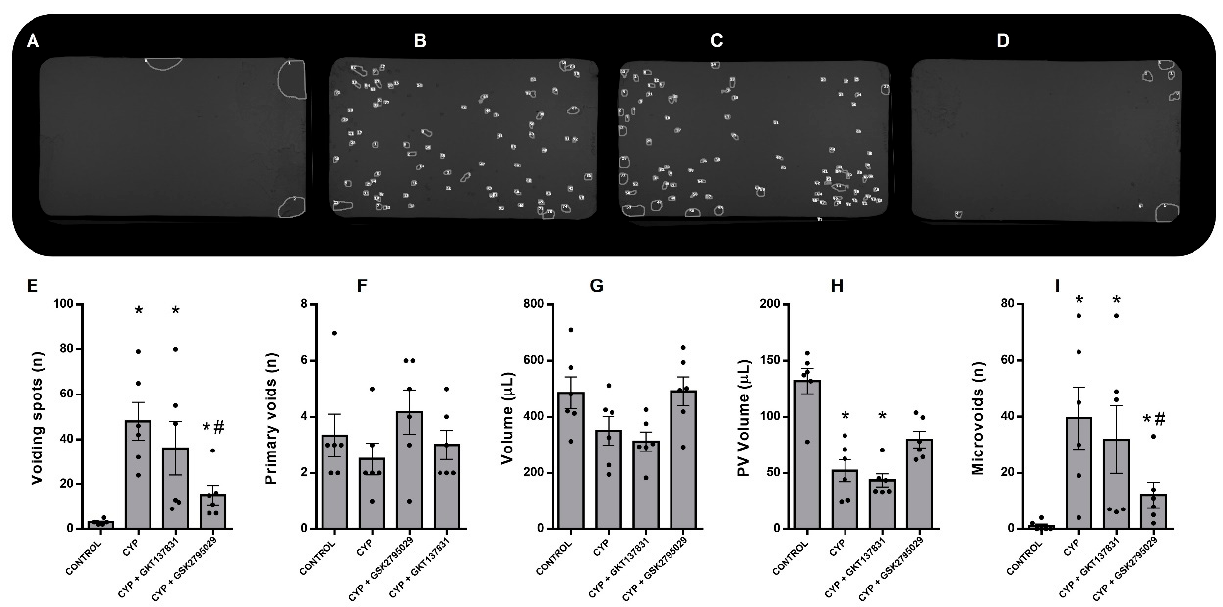
Figure 4. Void spot filter papers imaged under UV light ( A – D ). Automated spot detection of the control (saline) and cyclophosphamide (CYP, 300 mg/Kg, ip, 24 h)-injected animals untreated or treated (three doses in 24 h) with the NOX1/4 inhibitor GKT137831 (5 mg/Kg, ip) or NOX2 inhibitor GSK2795039 (5 mg/Kg, ip). The number of voiding spots ( E ), the number of primary voids (PV; greater than 20 µL; ( F )), the total volume ( G ), the PV volume ( H ), and the number of microvoids (( I ); less than 20 µL and greater than 2 µL). Summary data (mean ± SEM) represent n = 6 for all of the groups. Significance was tested by two-way ANOVA followed by multiple comparisons by Tukey’s post-hoc test. * p < 0.05 vs. CONTROL; # p < 0.05 vs. CYP.